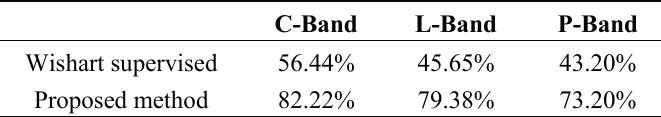
Table 12. Overall Accuracy of Wishart supervised method and proposed method using only 4